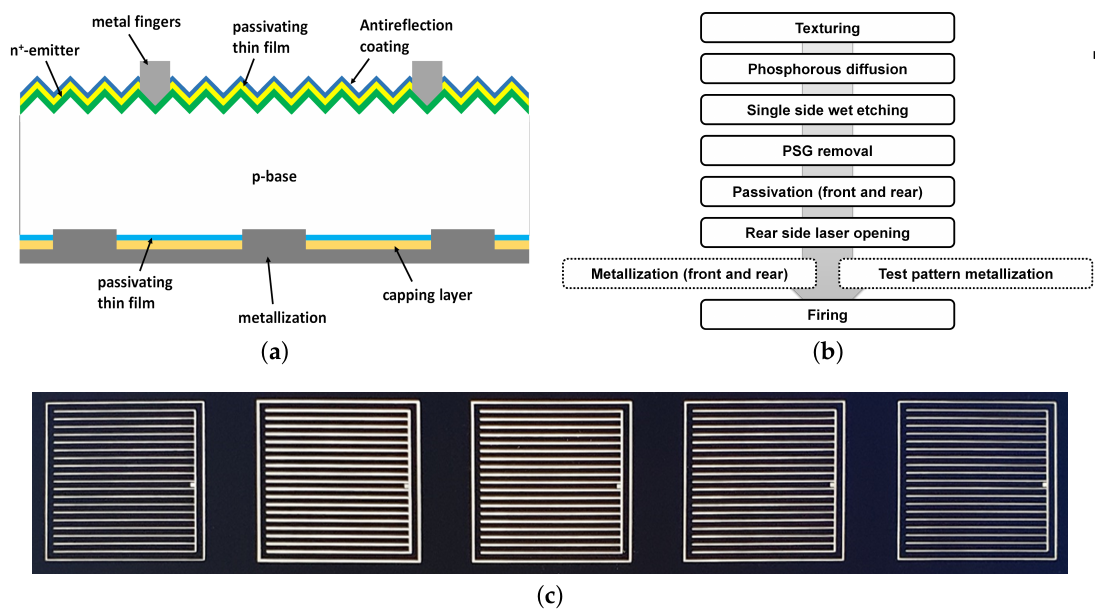
Figure 1. Passivated Emitter and Rear Contact (PERC) solar cell sample preparation, ( a ) PERC solar cell structure, ( b ) PERC solar cell manufacturing process, ( c ) metal pattern for measuring J 0. metal